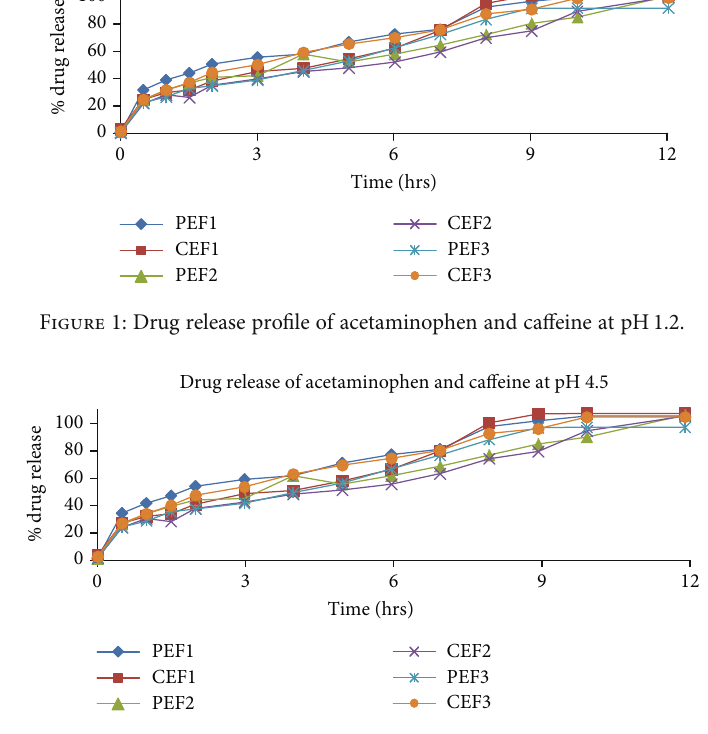
Figure 2: Drug release pro fi le of acetaminophen and ca ff eine at pH